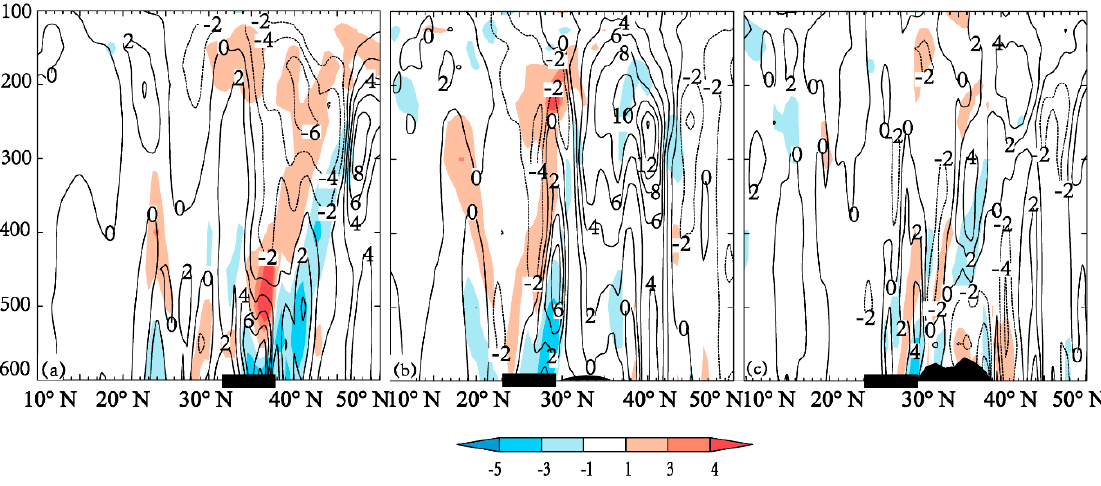
Figure 9. The vertical section of divergence anomalies (shade, unit: 10 − 5 s − 1 ) and vorticity anomalies (black solid line, unit: 10 − 5 s − 1 ) over the Tibetan Plateau for ( a ) the PT-type precipitation event at 100° E, ( b ) the PSL-type precipitation event at 99° E, and ( c ) the PV-type precipitation event at 90° E. The black rectangle on the horizontal axis represents the extreme precipitation area.